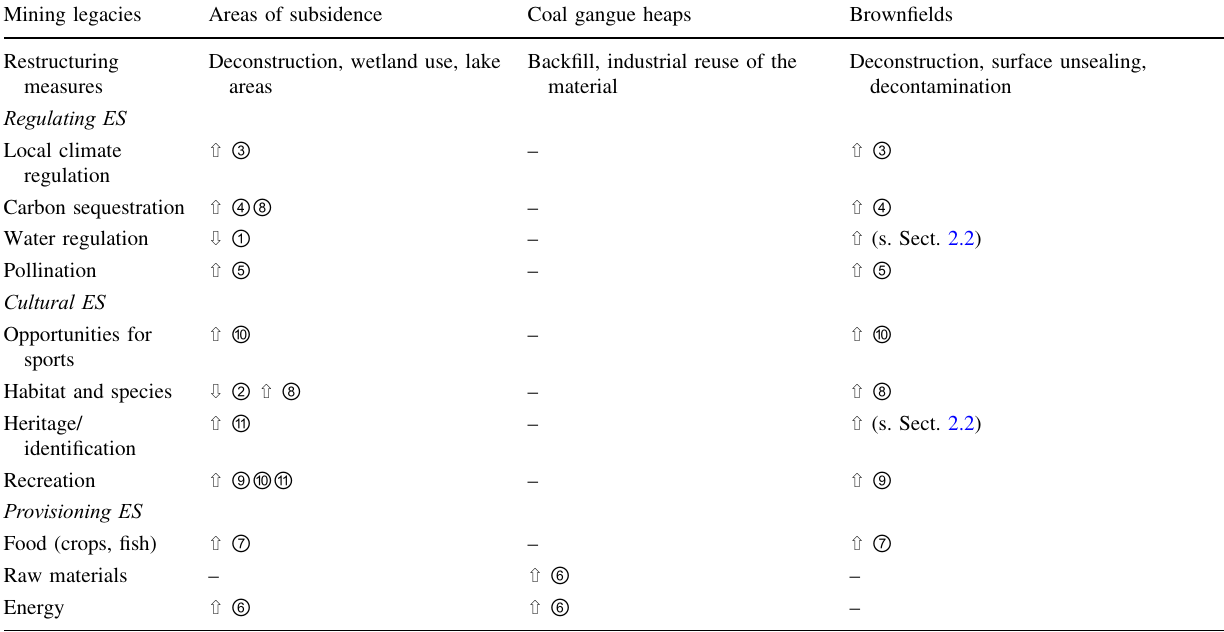
Table 2 Changes to ecosystem services when transforming mining legacies into green spaces (case of Xuzhou)